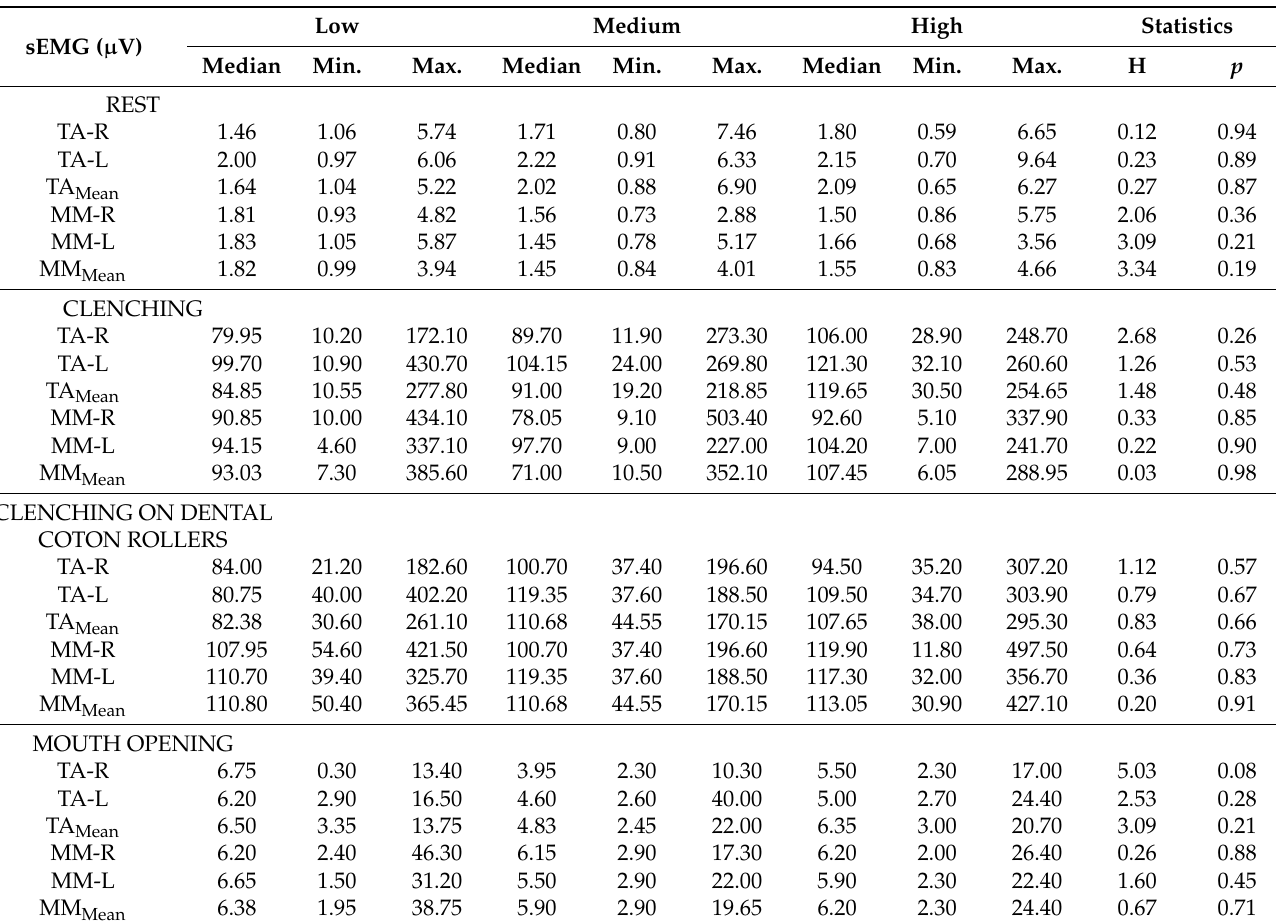
Table 2. Comparisons of sEMG (surface electromyography) activity in studied